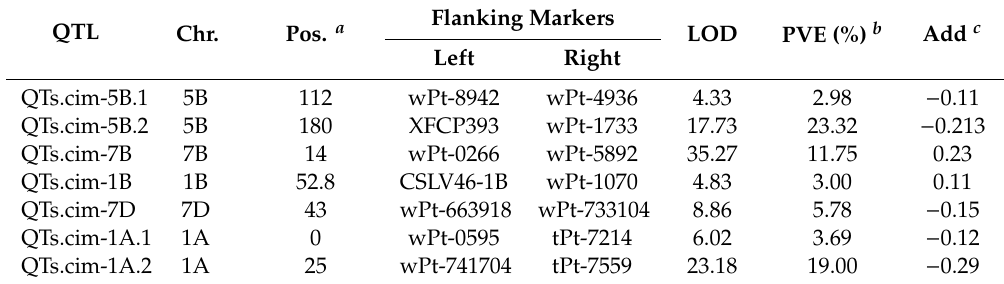
Table 3. QTLs for TS resistance in the population of PBW343 ( − ) / Kenya Nyangumi ( + ). Table 4. QTLs for SNB resistance in the population of PBW343 ( − )/Kenya Nyangumi (+).